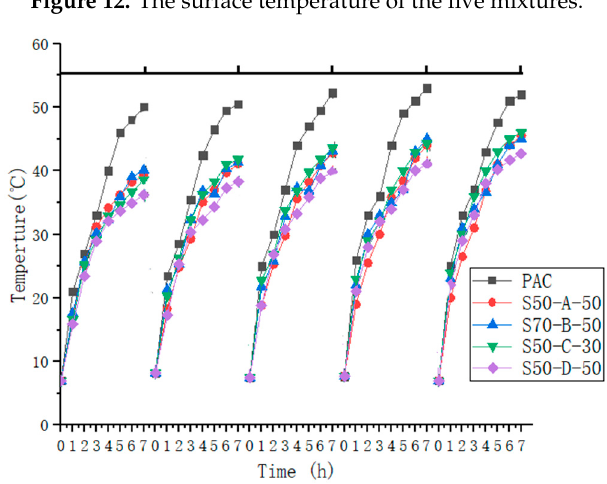
Figure 13. The internal temperature of the five mixtures.